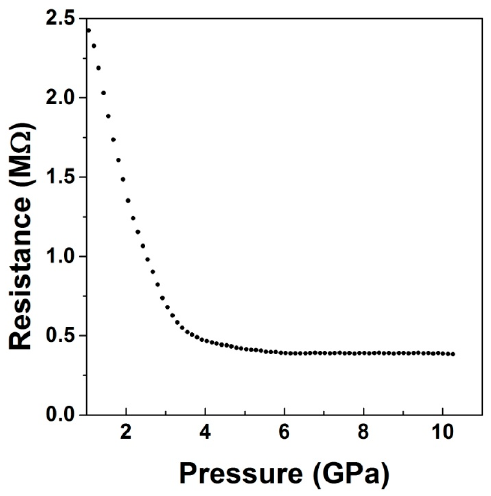
Figure 13. Pressure variation of electrical resistance of LiCrO 2 . The data indicates absence of structural or electronic transition in the compound.